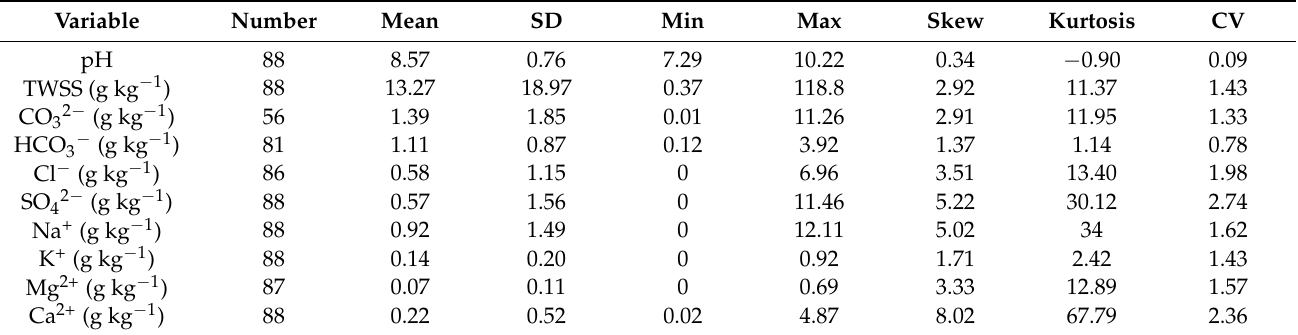
Table 5. Descriptive statistics of total water-solution salt (TWSS), pH, and base ions.